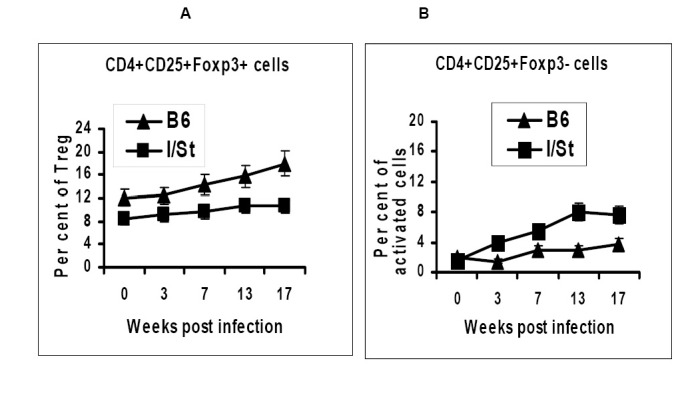
B6 and I/St mice differ in numbers (P< 0.05-0.01 at different time points, Student’s t-test) of regulatory (A) and activated (B) CD4+ T cells in mediastinal, lung-draining lymph nodes throughout the course of infection.